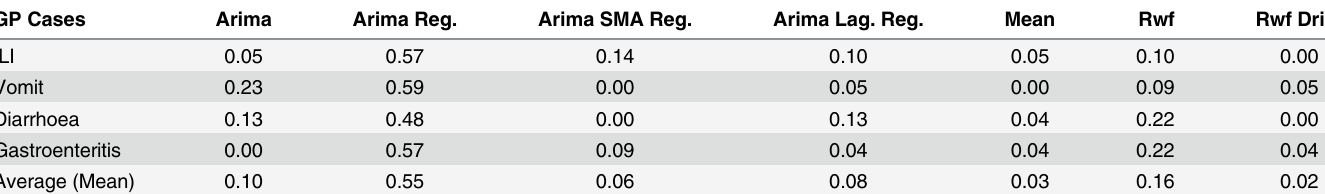
Table 7. Fraction of node/case pairs where model has minimum MAE (4-fold cross-validation).